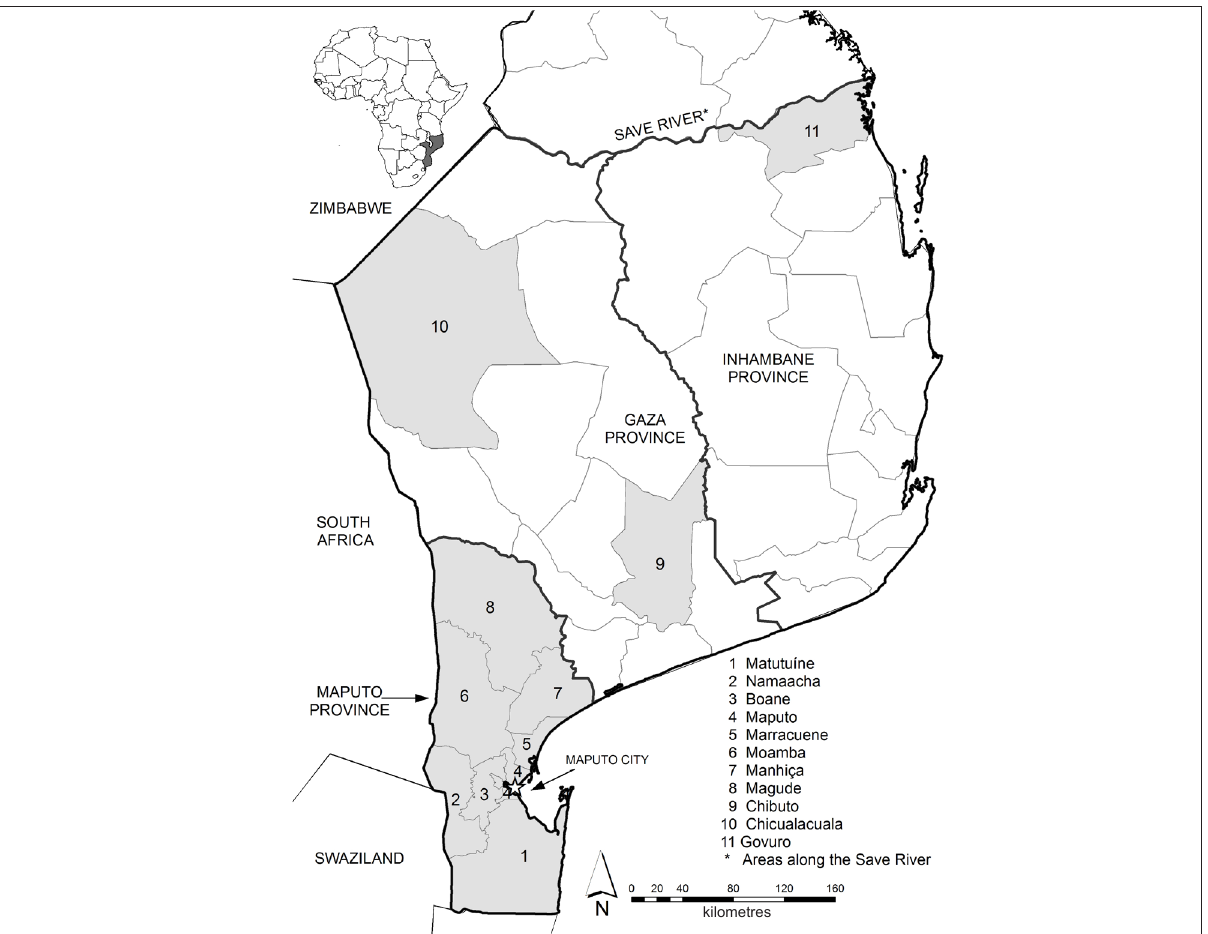
Figure 3: Map of Mozambique indicating the provinces and districts cited as source areas for the reptiles documented during the 2015/2016 market surveys.